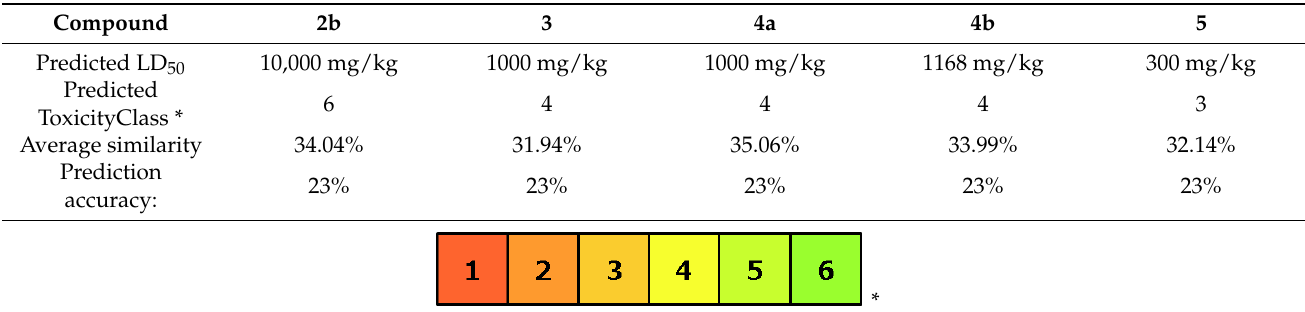
Table 11. Oral toxicity prediction results for all selected compounds.